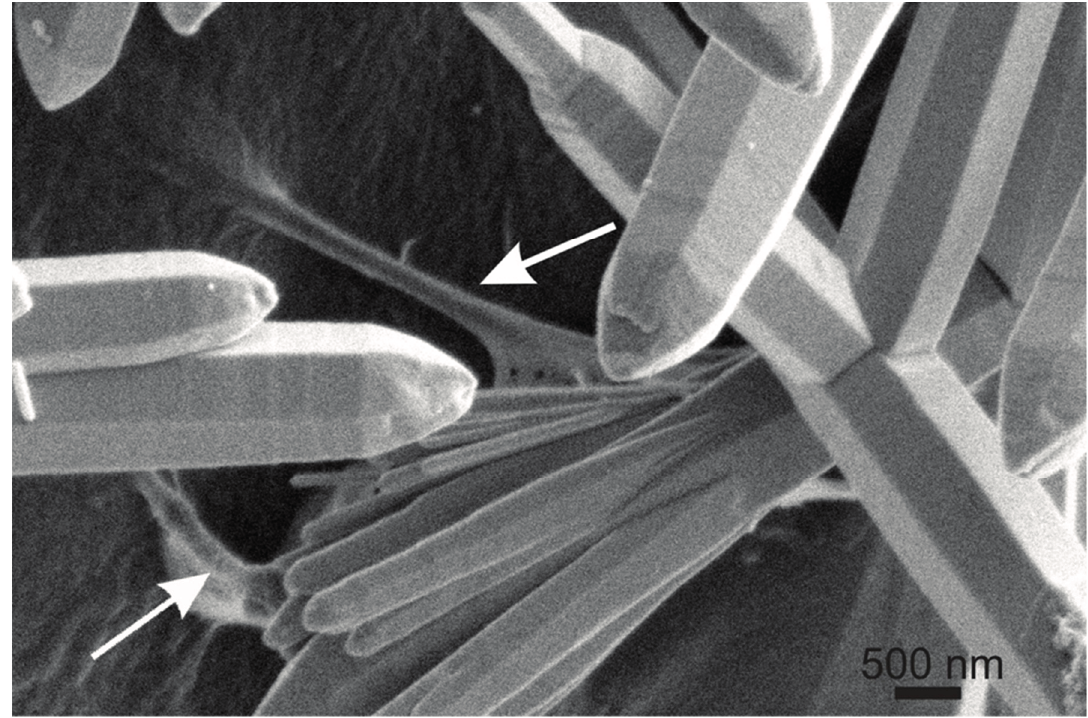
Figure 6. SEM image of the hydrothermally prepared β -chitin/ZnO composite. An arrow indicates the presence of β -chitin